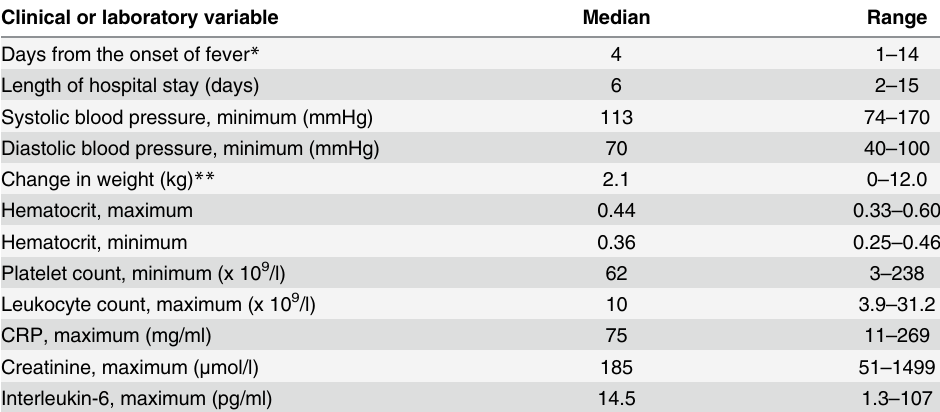
Table 1. The clinical and laboratory findings in 172 patients with acute Puumala hantavirus infection. Clinical or laboratory variable Median